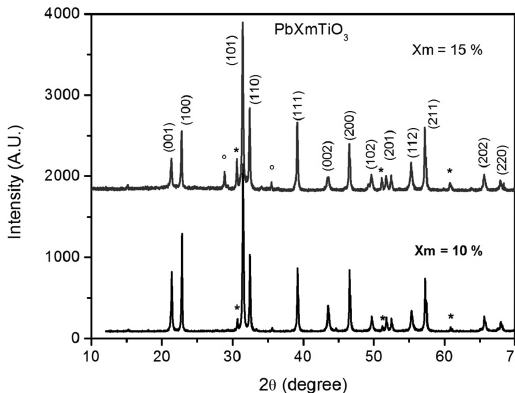
Figure 4. X-ray diffraction patterns of PXT10 and PXT15 powders calcinated at 1000 °C, where (*) represents pyroclore phase and (°) PbO phase.